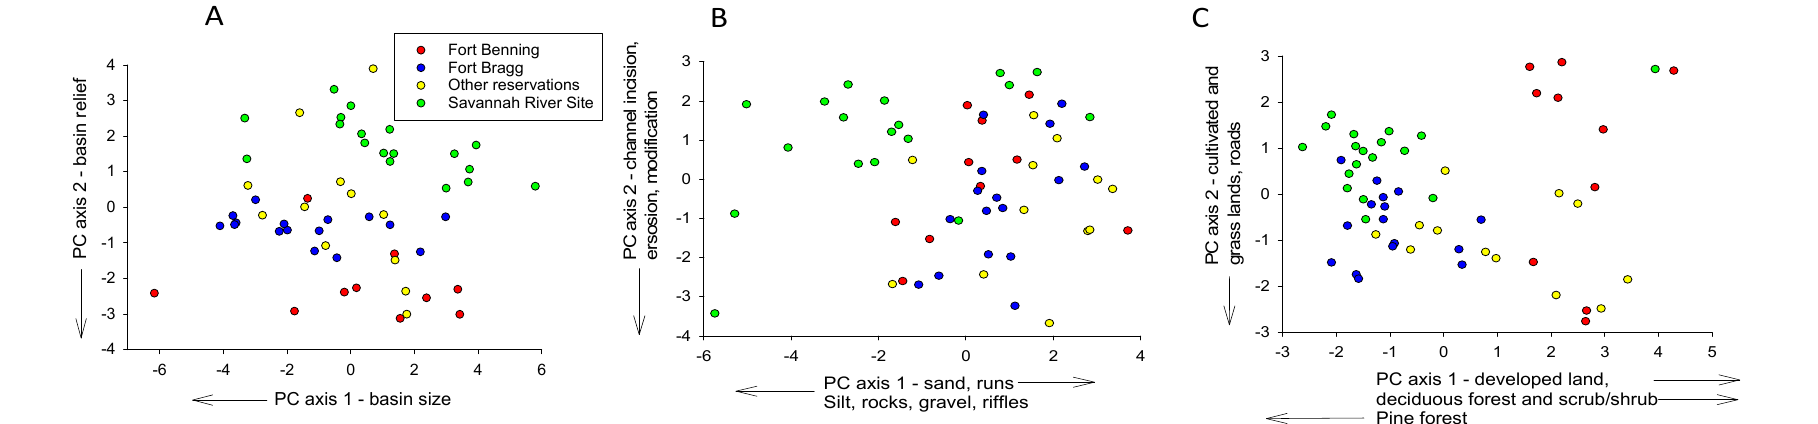
Figure 6. Principal Components Analyses of sample sites based on variables representing ( A ) basin size, shape, and relief, ( B ) instream habitat variables, and ( C ) land cover variables. Also shown are variables with the strongest effect on each axis plus their direction of increase.